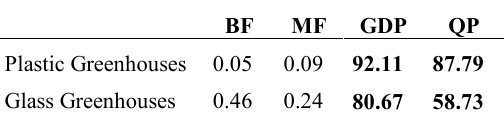
Table 4. The quantitative evaluation of obtained